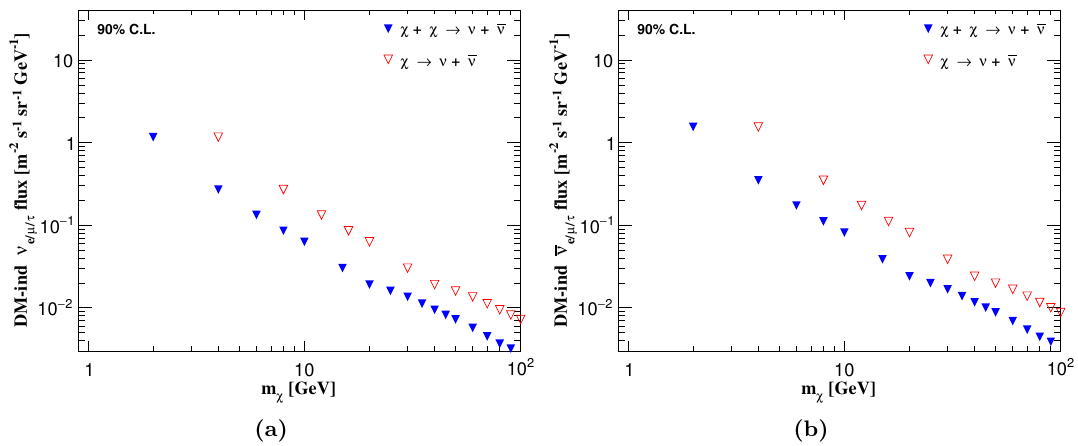
Figure 9. The limit on (a) (cid:23) and (b) (cid:22) (cid:23) (cid:13)ux produced from the dark matter in Milky e=(cid:22)=(cid:28) e=(cid:22)=(cid:28) Way galaxy at 90% C.L. (1 d.o.f.) by 500 kt (cid:1) yr MagICAL detector. The blue (cid:12)lled and red empty triangles are for the annihilation and decay of dark matter particles